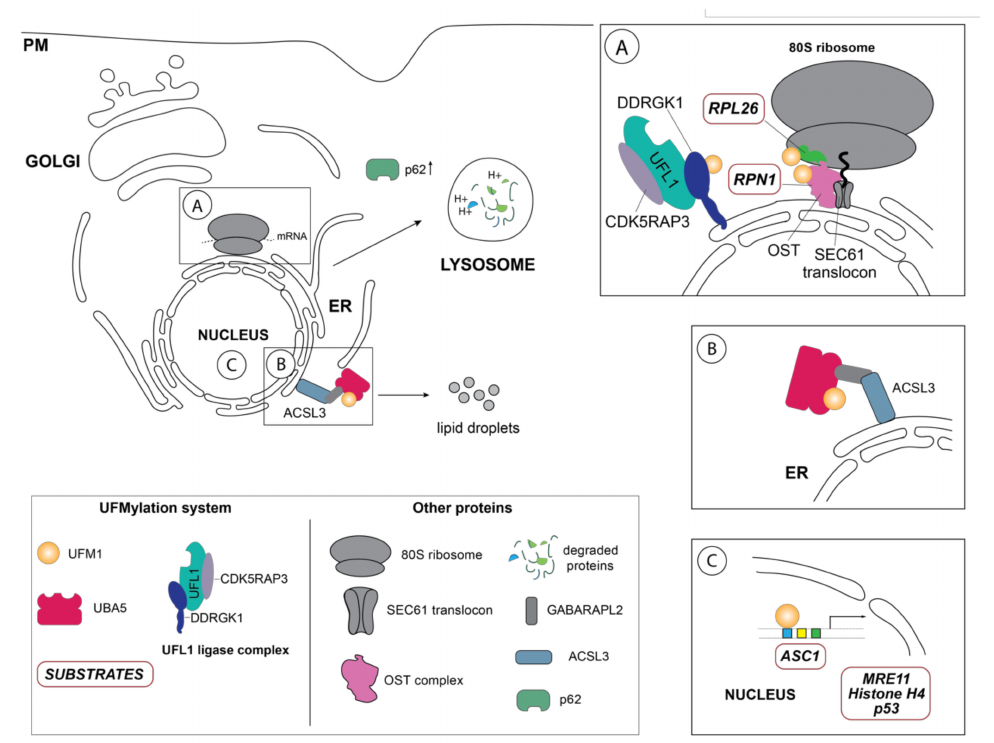
Figure 2. Schematic overview of the so far identified UFM1 substrates and UFM1 enzymes in their respective cellular localization. ( A ) One of the principal UFM1 substrates—the ribosomal protein RPL26—is UFMylated by the orchestrated action of the UFM1 E3 ligase complex consisting of UFL1, CDK5RAP3 and DDRGK1 and contributes to ERAD as well as an alternative ribosomal quality control mechanism following ribosomal stalling at the SEC61 translocon during co- translational protein targeting and ultimately lysosomal degradation of these aberrant proteins [35,36]. The autophagy cargo adaptor p62 (also sequestosome-1 (SQSTM1) has been found in several studies to indirectly regulate autophagy by UFMylation, although the exact mechanistic details are unclear [59]. Additionally, DDRGK1, an adaptor protein recruiting UFL1 to the ER membrane and modulating its ligase activity, is regulated by UFMylation itself and participates in the degradation of ER sheets [38]. Ribophorin I (RPN1), a protein of the oligosaccharyltransferase (OST) complex, has also been reported to be UFMylated [38]. ( B ) Inset depicts the GABARAPL2-mediated interaction between the long-chain-fatty-acid CoA ligase 3 (ACSL3) and UBA5, relocalizing it to the ER membrane and stimulating UFMylation [56]. ( C ) Schematic representation of the nuclear UFMylation substrates, which include the activating signal co-integrator 1 (ASC1), as well as DNA damage repair proteins such as the double strand repair protein MRE11, histone H4, and